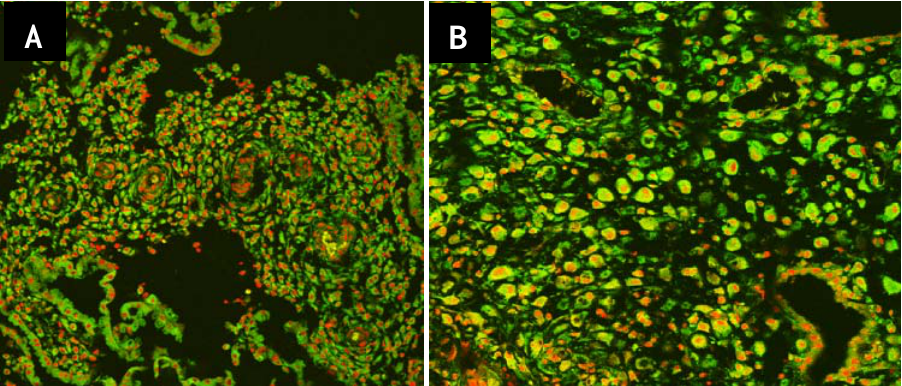
Figure 4. Immunofluorescence in the cytoplasm and nuclear translocation with NF- κ B protein p65 in deciduas. (A), Control; (B), Early spontaneous miscarriage. CLSM × 200 (Green color indicates positive staining for NF- κ B protein p65; Red color indicates nuclei).